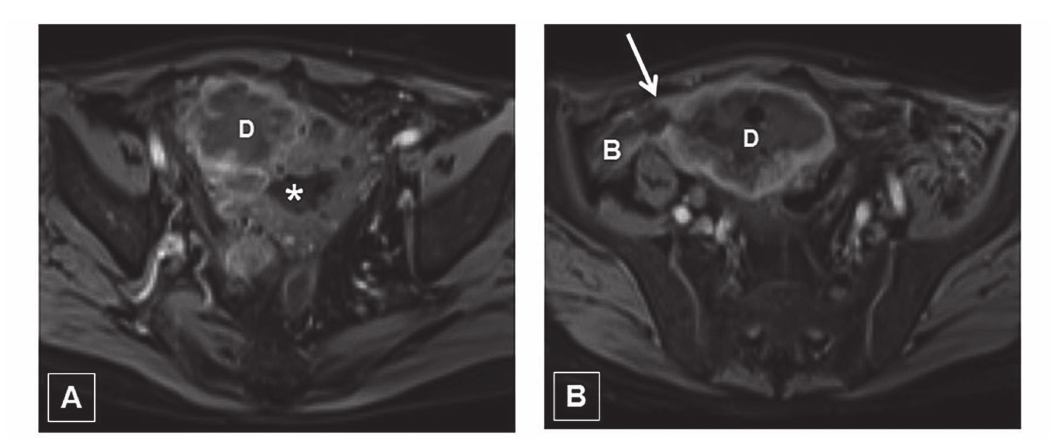
Figure 1 - Enterovesical fistula secondary to diverticulitis. T1-weighted axial MR images (A-B) with intravenous contrast medium shows thick-walled diverticulum (D) and fistula track (arrow) between diverticulum (D) and bowel (B). T2-weighted axial MR images (C-D) shows bladder diverticulum (D) and large fistula track (arrow) between diverticulum (D) and bowel (B). Asterisk: